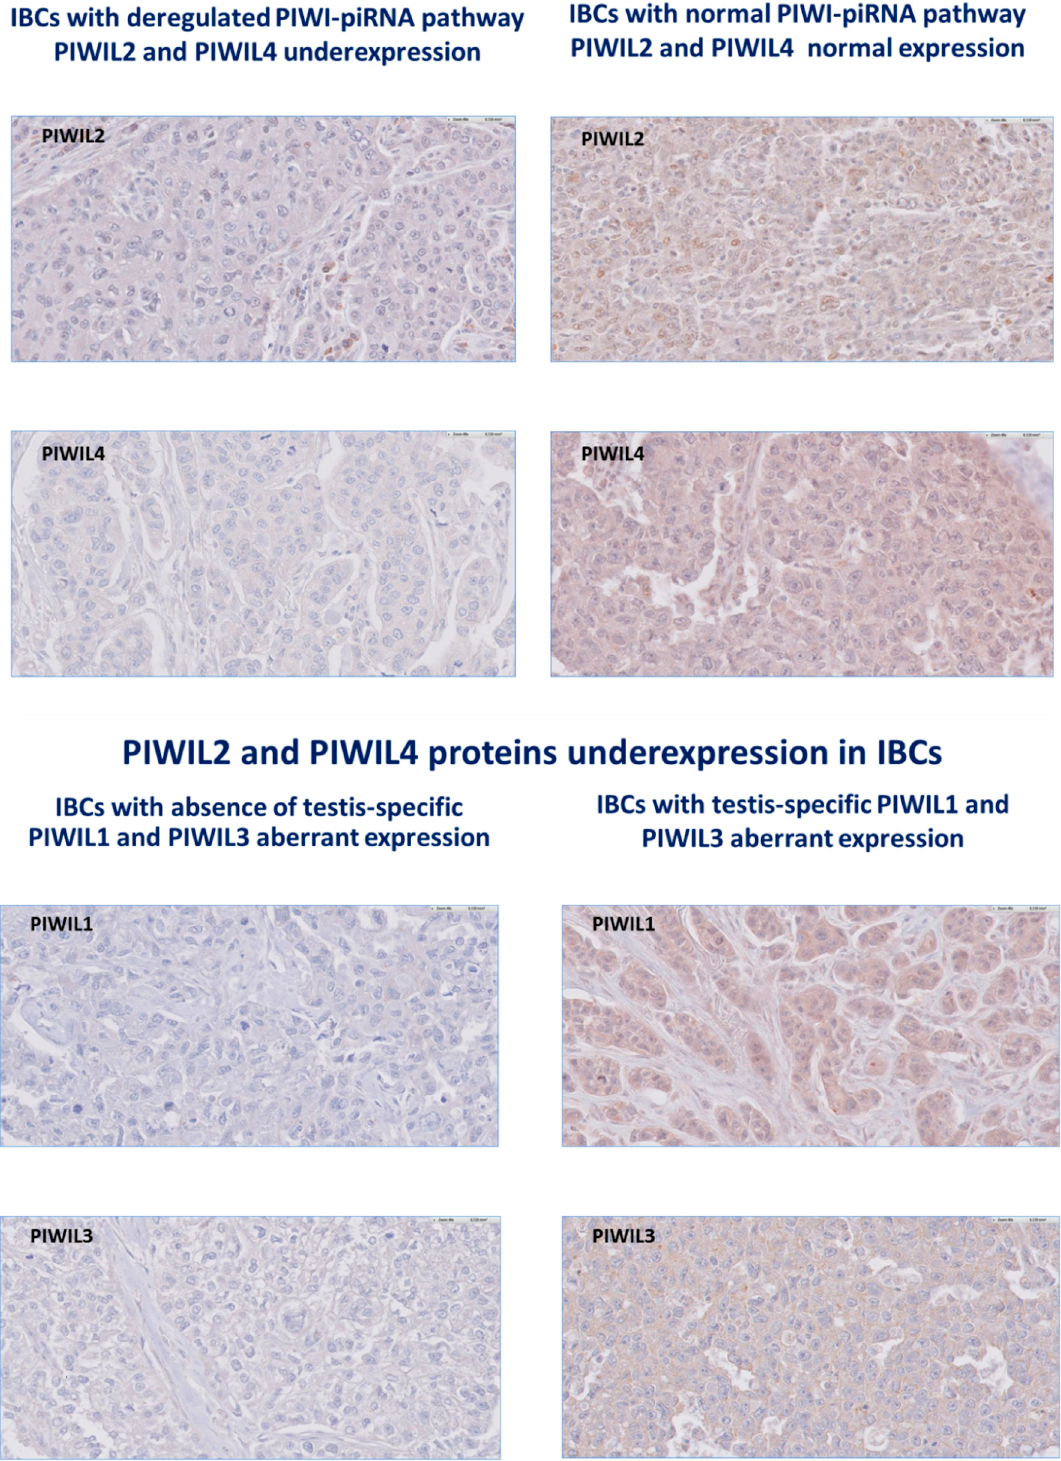
Figure 1. Invasive breast carcinomas (IBCs) are characterized by deregulation of all proteins PIWIL1-2-3-4. At magnification ×200. Table 3. PIWIL1-2-3-4 mRNA levels of expression in a series of IBCs ( n = 526) with molecular subtypes.